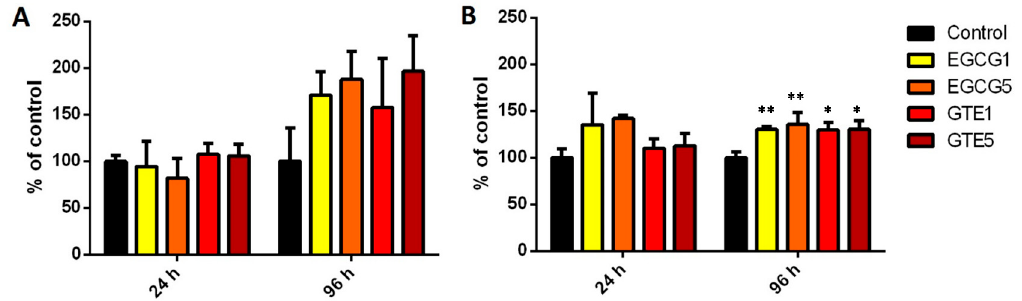
Figure 2. GST activity in ( A ) proliferating and ( B ) differentiated Caco-2 cells incubated with 1 and 5 µg/mL EGCG and GTE for 24 and 96 h. The bars represent means ± SD after at least three independent measurements. Significance of differences from the control was determined by ANOVA followed by a Dunnett’s test (* p < 0.05, ** p < 0.01).